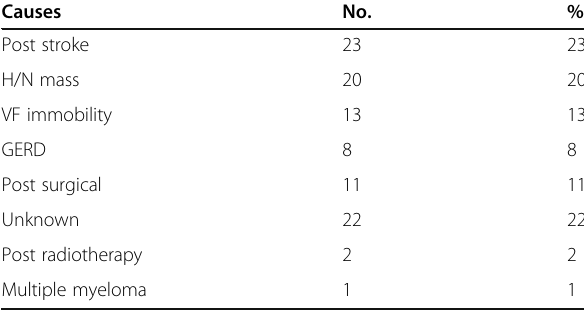
Table 2 Classification of cases according to the cause